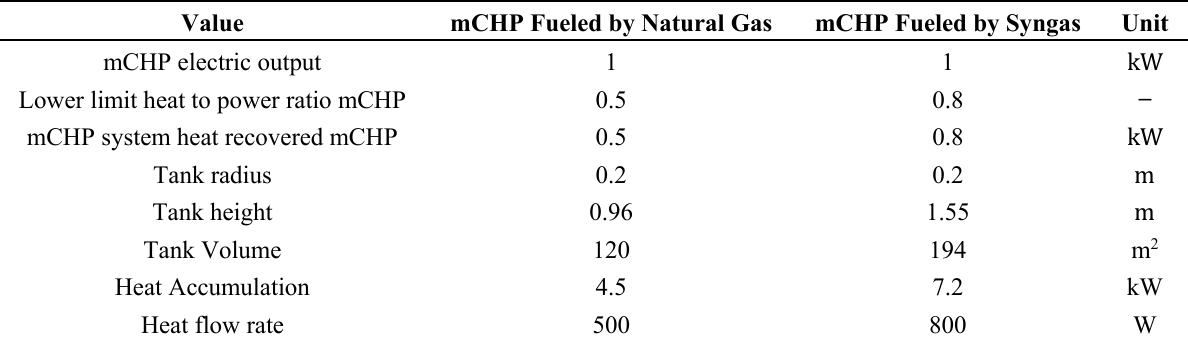
Table 4. Designing values for the tank sizing in case of mCHP fueled by natural gas and by